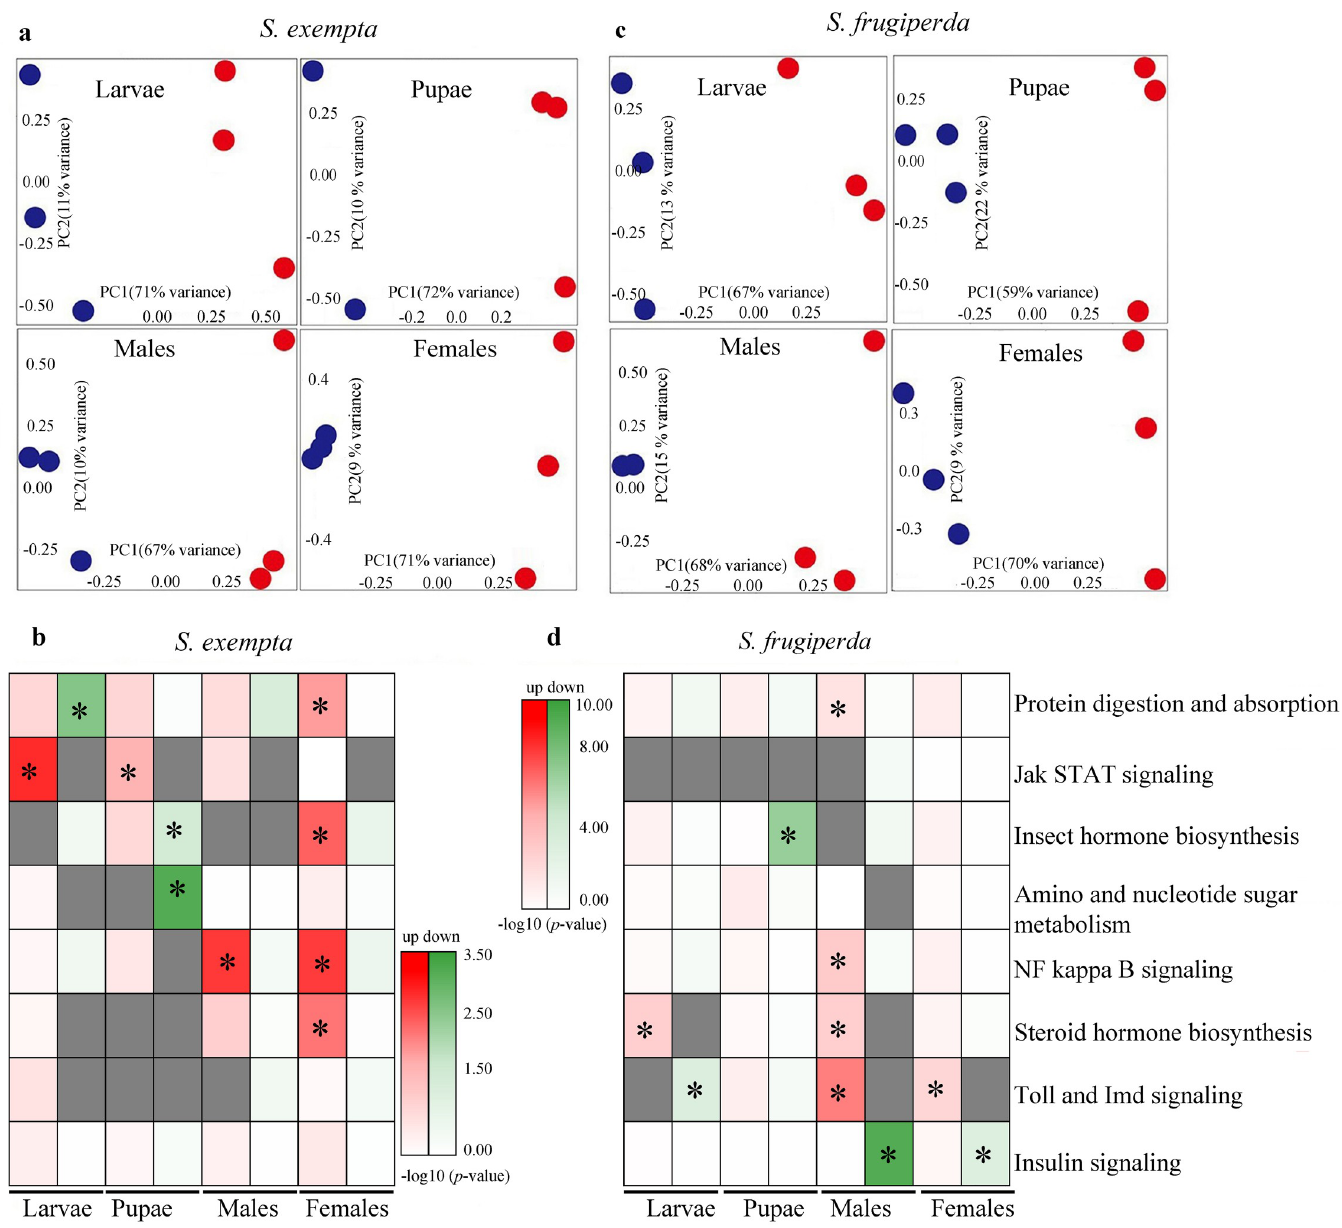
Fig 5. Transcriptome analysis using the partiti-like virus-positive individuals compared to related virus-negative individuals in S . exempta and S . frugiperda . (a,c) PCA analysis of global gene expression of DEGs in the comparison of partiti-like virus-positive groups and related virus-negative groups in S . exempta (a) and S . frugiperda (c). Blue stands for the partiti-like viruses-positive samples and red stands for the partiti-like viruses-negative samples. (b,d) Heatmaps of–log10 p -values of KEGG pathway representing the up- and down- regulated DEGs in S . exempta (b) and S . frugiperda (d). “ � ” indicate the significantly enriched pathways (p < 0.05). Red color shows up-regulation pathways, green color show down-regulation pathways, gray color shows no value, the redder/greener the color, the lower P -values.